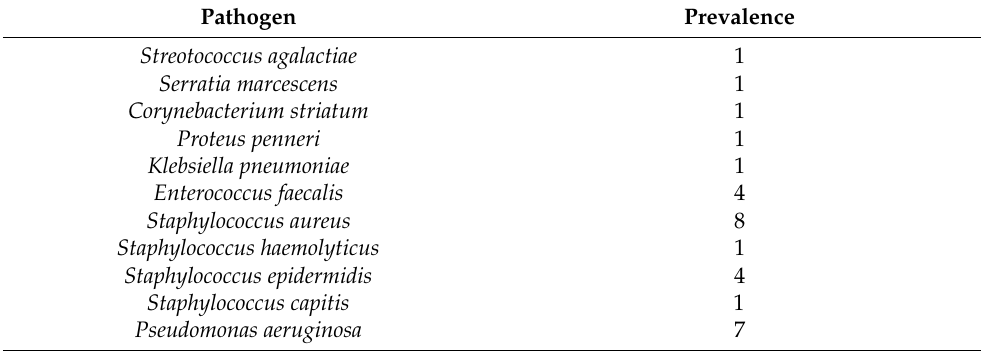
Table 3. Pathogen spectrum of complex wounds with the corresponding prevalence. In the mi- crobiological wound swabs, 9 wounds showed an isolated pathogen, whereas 9 wounds showed colonization with a mixed flora. Only 2 wound swabs were found to be sterile. (Patient population n = 20).